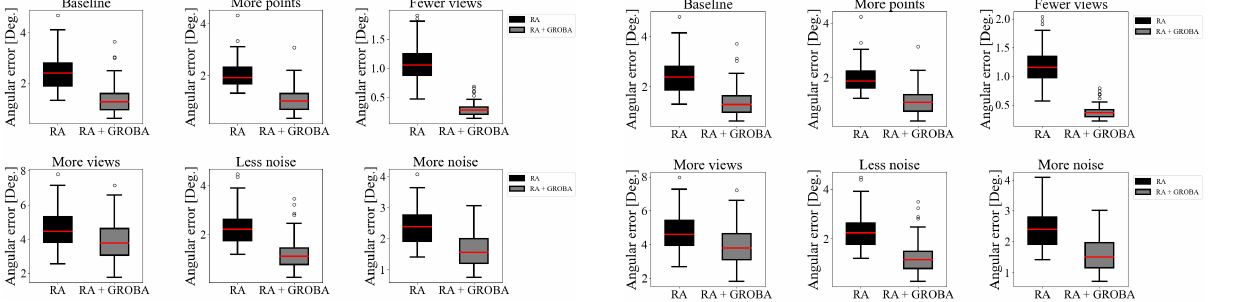
Figure 5: Results of the synthetic data test settings. Comparison between RA and G-ROBA (initialized by RA) in terms of the mean angular error after the L 2 alignment.